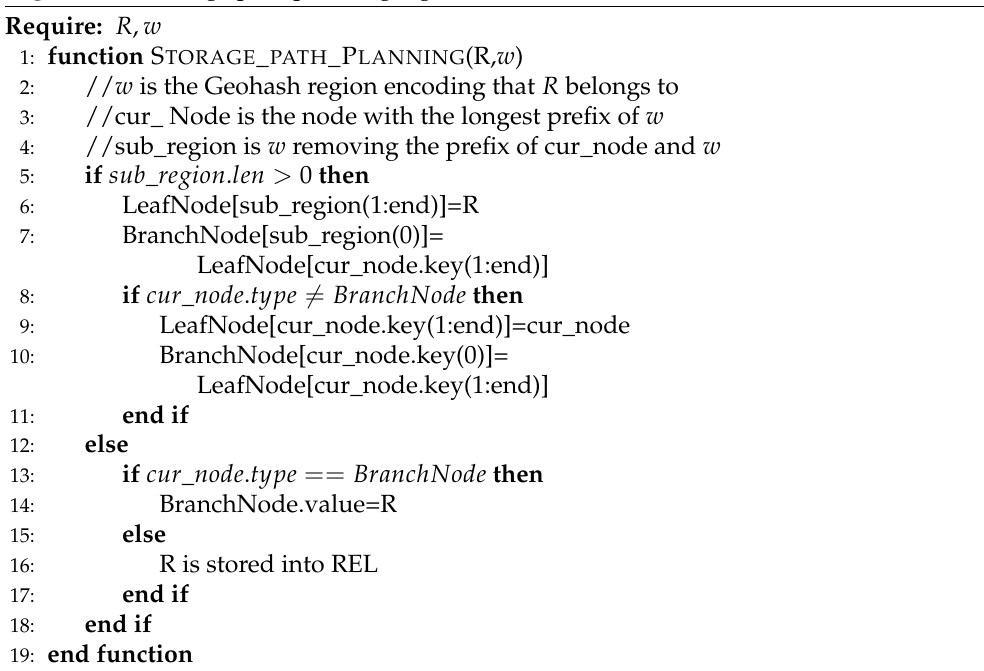
Algorithm 1 Storage path planning algorithm of